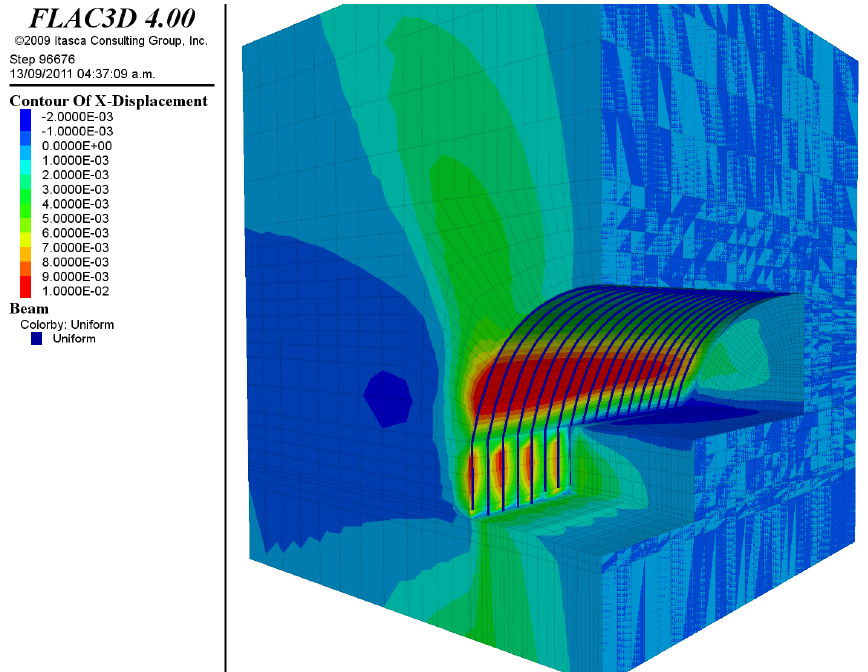
Figure 29. Horizontal displacements (Ux in meters) in an intermediate stage of the excavation. Minimum parameters.